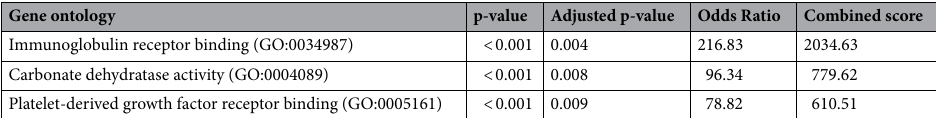
Table 4. GO analysis molecular function by Enrichr. Proteins that correlated with PC1 or PC2 and were increased among patients with AKI as compared to patients without AKI were used to identify pathways affected by sepsis-AKI.